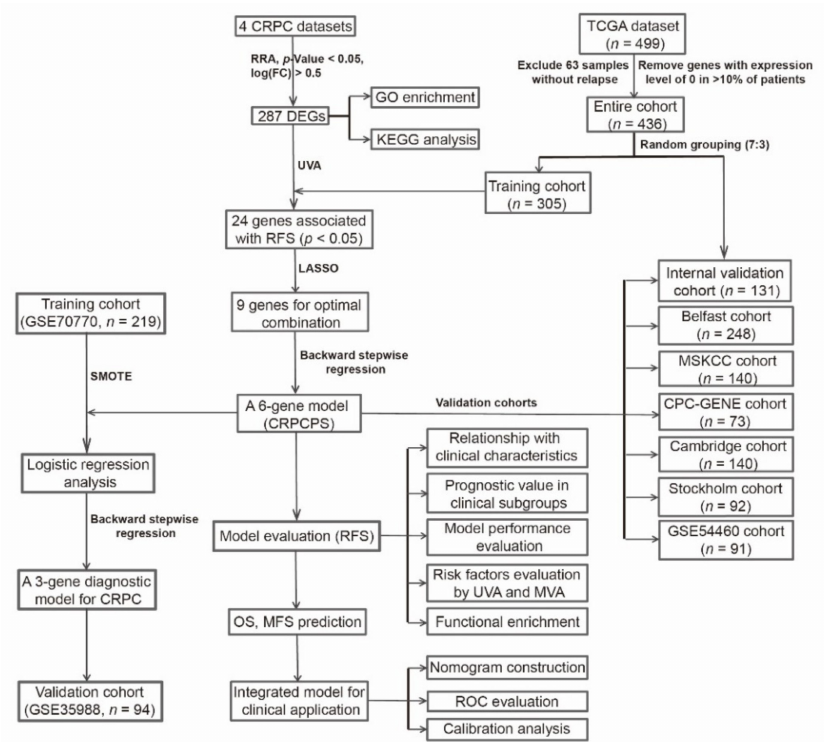
Figure 1. The workflow of the study. CRPC: castration-resistant prostate cancer; RRA: Robust Rank Aggregation; LASSO: Least absolute shrinkage and selection operator; DEGs: differentially expressed genes; UVA: Univariate Cox regression analysis; GO: Gene Ontology; KEGG: Kyoto Encyclopedia of Genes and Genomes; RFS: recurrence-free survival; CRPCPS: CRPC-derived prognostic signature; GSVA: Gene set variation analysis; SMOTE: synthetic minority over-sampling technique; ROC: receiver operating